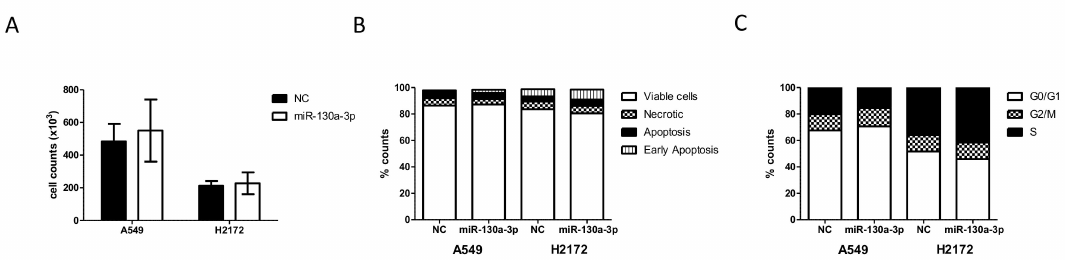
Figure 11. ( A ) Cell counts, ( B ) apoptosis and ( C ) cell cycle of A549 and H2172 NSCLC cell lines after transfection with miR-130a-3p or scrambled control (NC) at 72 h. Cell counts are expressed as the mean ± standard deviations (four experiments). Stacked plots are the mean of four different experiments. Standard deviation was below 5% of the